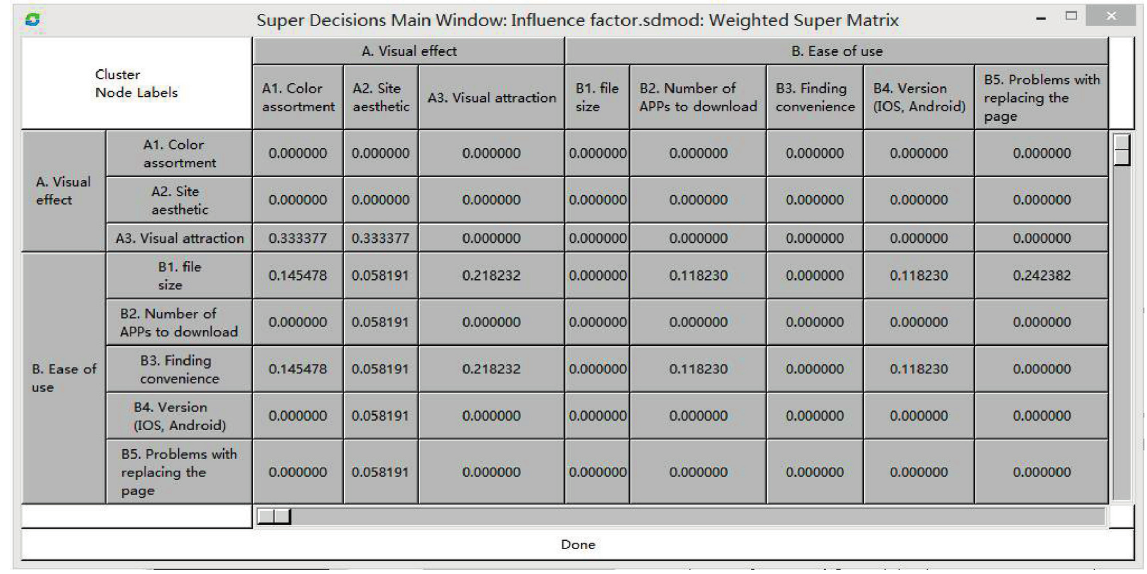
Figure 6: Implementation of the weighted supermatrix.